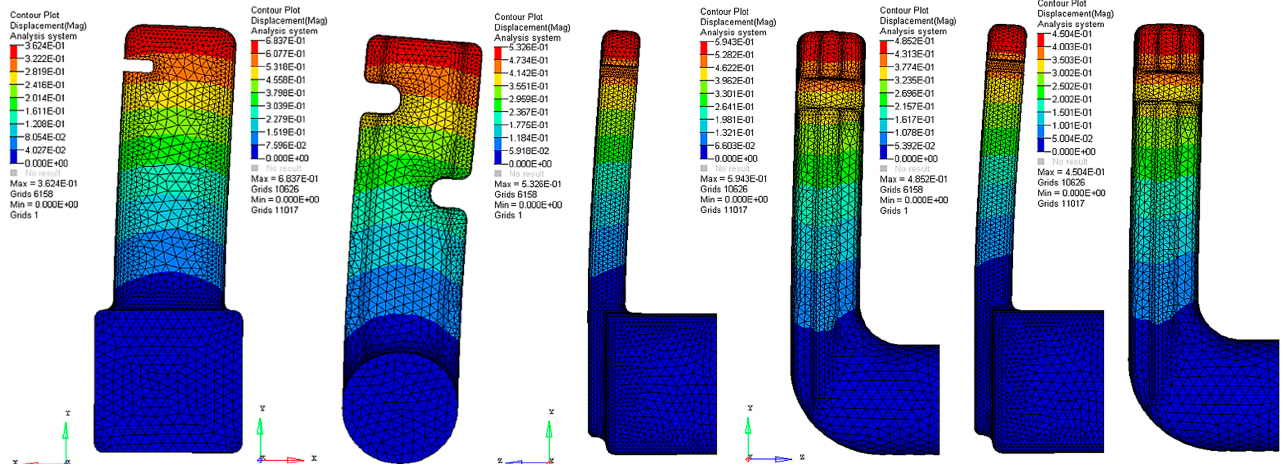
Figure 14. Pair on the left are deformations (LC load A1), pair in the middle are PA deformations (vector sum of X, Y, Z directions, unit mm, Load LC_B1) and last pair on the right are deformations (Load LC_C1),.